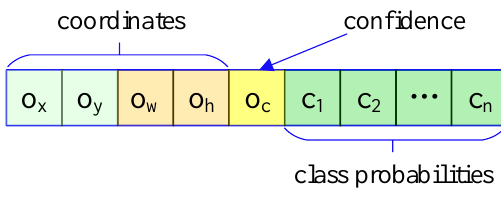
Figure 2. The output format of each grid.